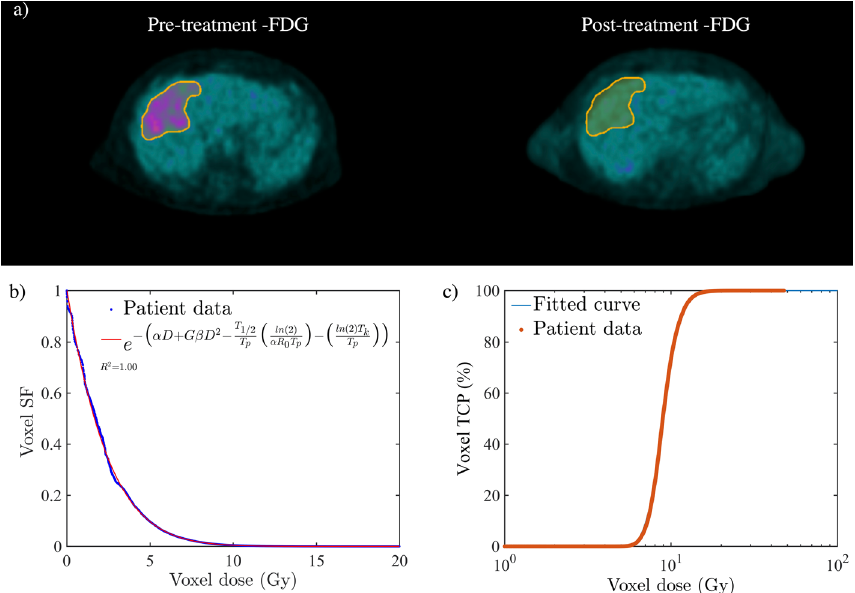
Fig. 1 Complete metabolic response (CMR) for a patient with cholangiocarcinoma liver malignancy. Deformable PET images and corresponding calculated voxel survival fraction (VSF) and tumour control probability (TCP). a The deformably registered pre ‐ and post-treatment [ 18 F] FDG PET images. The registration provided a one ‐ to ‐ one correlation between voxels on pre ‐ and post-treatment [ 18 F] FDG PET images. b , c The estimated voxel SF and TCP. The survival fraction and TCP were calculated based on the 90 Y absorbed dose and SUV volume histograms. The radiobiological parameters were derived from the generalised linear– quadratic (GLQ) fit (see Table 1)